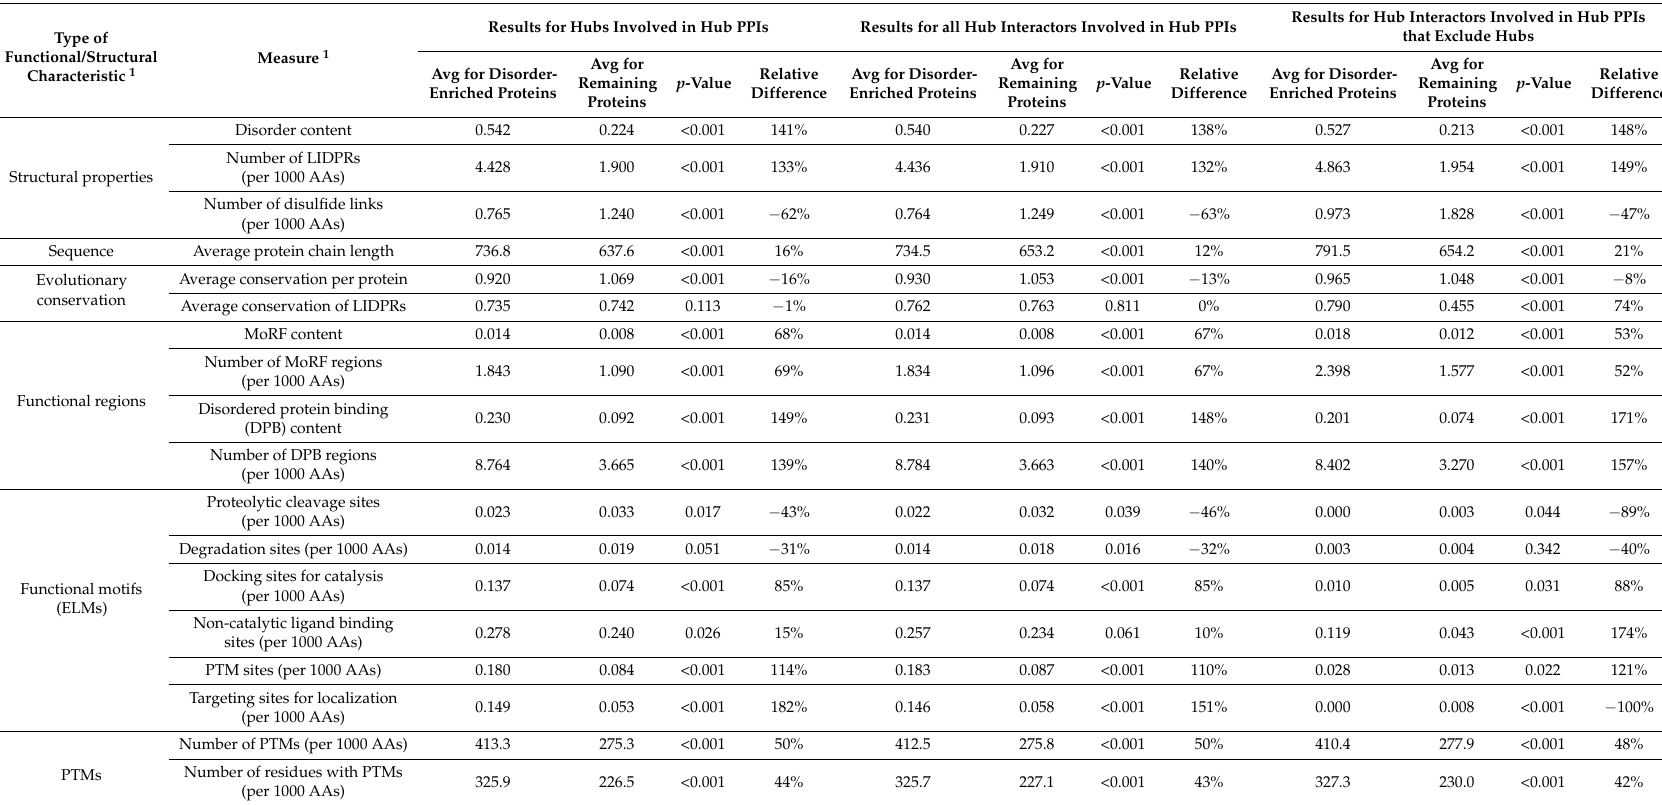
Table 1. Analysis of enrichment in functional and structural characteristics of proteins. We compare hubs/hub interactors/hub interactors that exclude hubs that are associated with the disorder-enriched hub protein-protein interactions (PPIs) that have disorder content higher than expected by over 50% vs. the remaining hubs/hub interactors/hub interactors that exclude hubs. To ensure that results are statistically robust to represent diverse subpopulations of these proteins, we select 20% of proteins at random from each of the two protein sets, quantify a given characteristic for each set, and repeat this ten times. We report the average of the ten repetitions and the relative difference between averages for the two protein sets. We also evaluate the significance of the differences between these measurements. We use the t-test if the data are normal (we test normality with the Anderson-Darling test at p -value = 0.05); otherwise we use the Wilcoxon test. Bold font indicates large differences that are statistically significant ( p -value < 0.001 and |relative difference| ≥